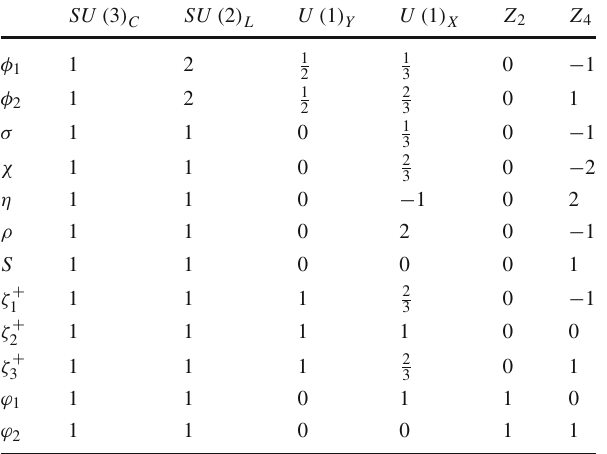
Table 3 Lepton assignments under SU ( 3 ) C × SU ( 2 ) L × U ( 1 ) Y × U ( 1 ) X × Z 2 × Z 4 . Here i = 1 , 2 , 3 and n = 1 , 2